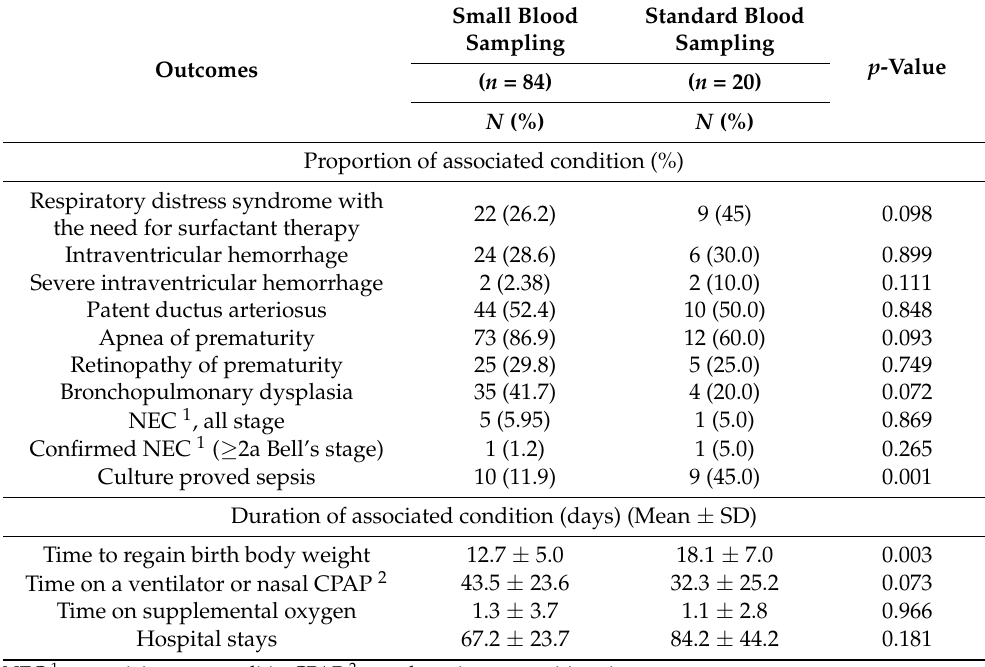
Table 5. Clinical